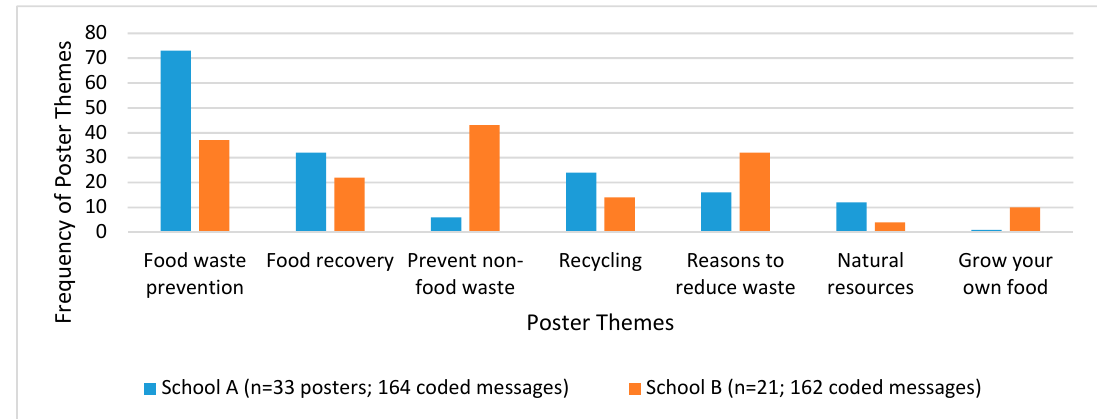
Figure 2. Student poster content analyses results, by school. A total of 54 posters were completed across both schools featuring 326 food systems themes. (Posters were completed in groups or individually, depending on teacher preference.) Food recovery are actions to avoid landfill disposal of wasted food, such as composting.